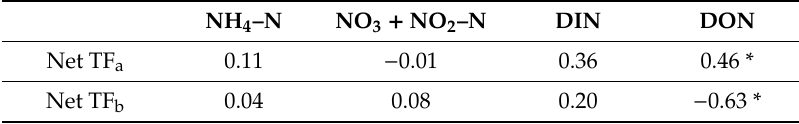
Table 4. Spearman correlations between rainfall amount (mm) and fluxes of dissolved nitrogen in